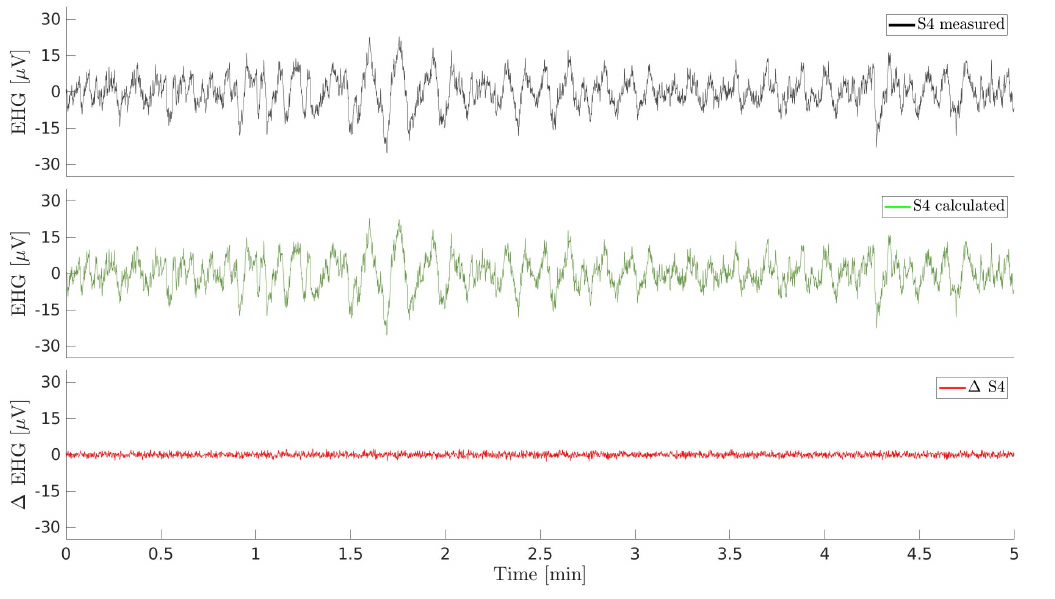
Figure A1. A five-minute excerpt of an originally recorded EHG signal S 4 M (upper trace), calculated EHG signal S 4 C (middle trace), and the difference between samples of signals, ∆ S 4 (lower trace), of a selected term EHG record. The standard deviation (Equation (A1)) for this entire record equals 0.78 ( µ V) 2 .